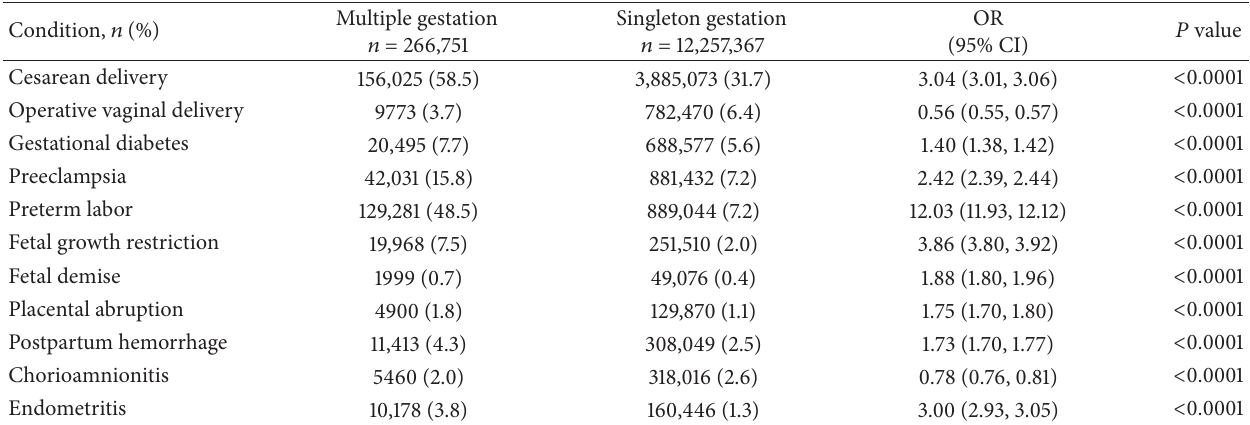
with singleton gestation, Nationwide Inpatient Sample for years 2008–2010 (12,524,118